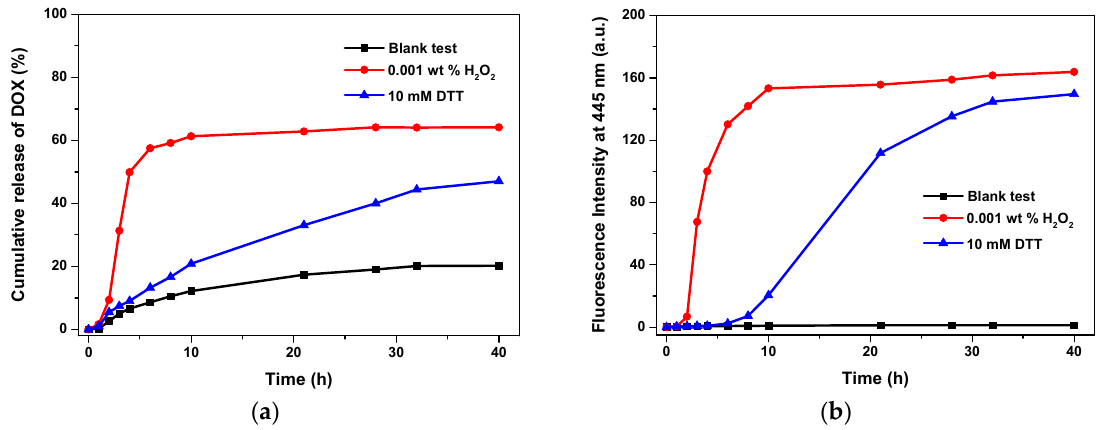
Figure 4. ( a ) Doxorubicin (DOX) release behavior of SeSe 0.01 -PAA-TPE 0.02 under different conditions; ( b ) fluorescence changes in reaction solution during DOX release ( λ Ex = 340 nm, slit width for Ex. and Em. = 5.0, PMT = 400V).